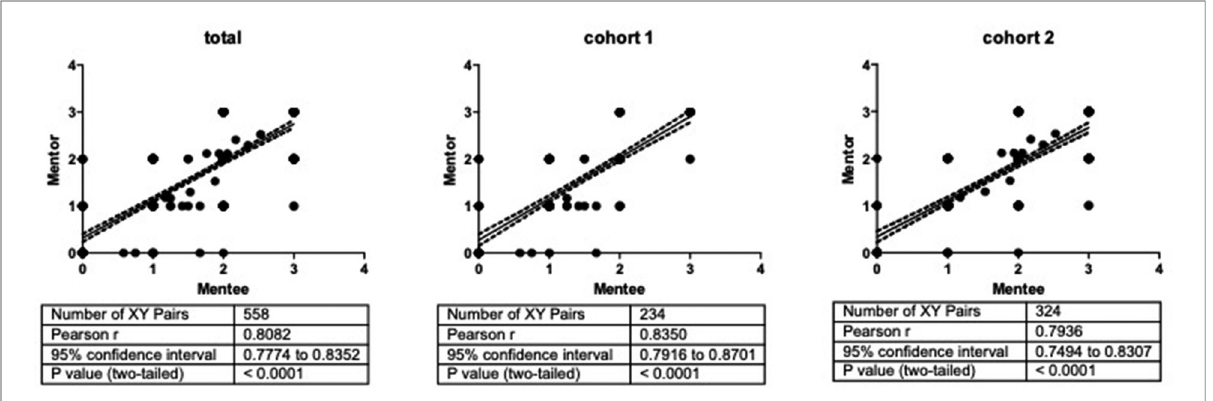
FIGURE 2 Mentee/mentor assessments correlations. The fi gure shows Pearson correlations (solid lines) along with their 95% con fi dence intervals (dashed lines). Individual panels show mentee/mentor correlations for all mentees (left panel) and only mentees of cohort 1 (central panel) or cohort 2 (right panel), respectively. x - and y -axis units are levels of